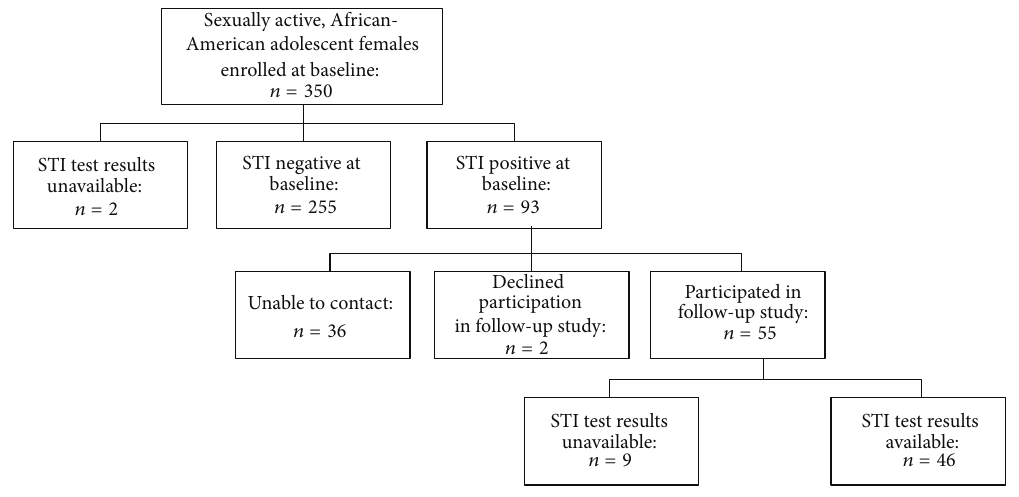
Figure 1: Disposition of